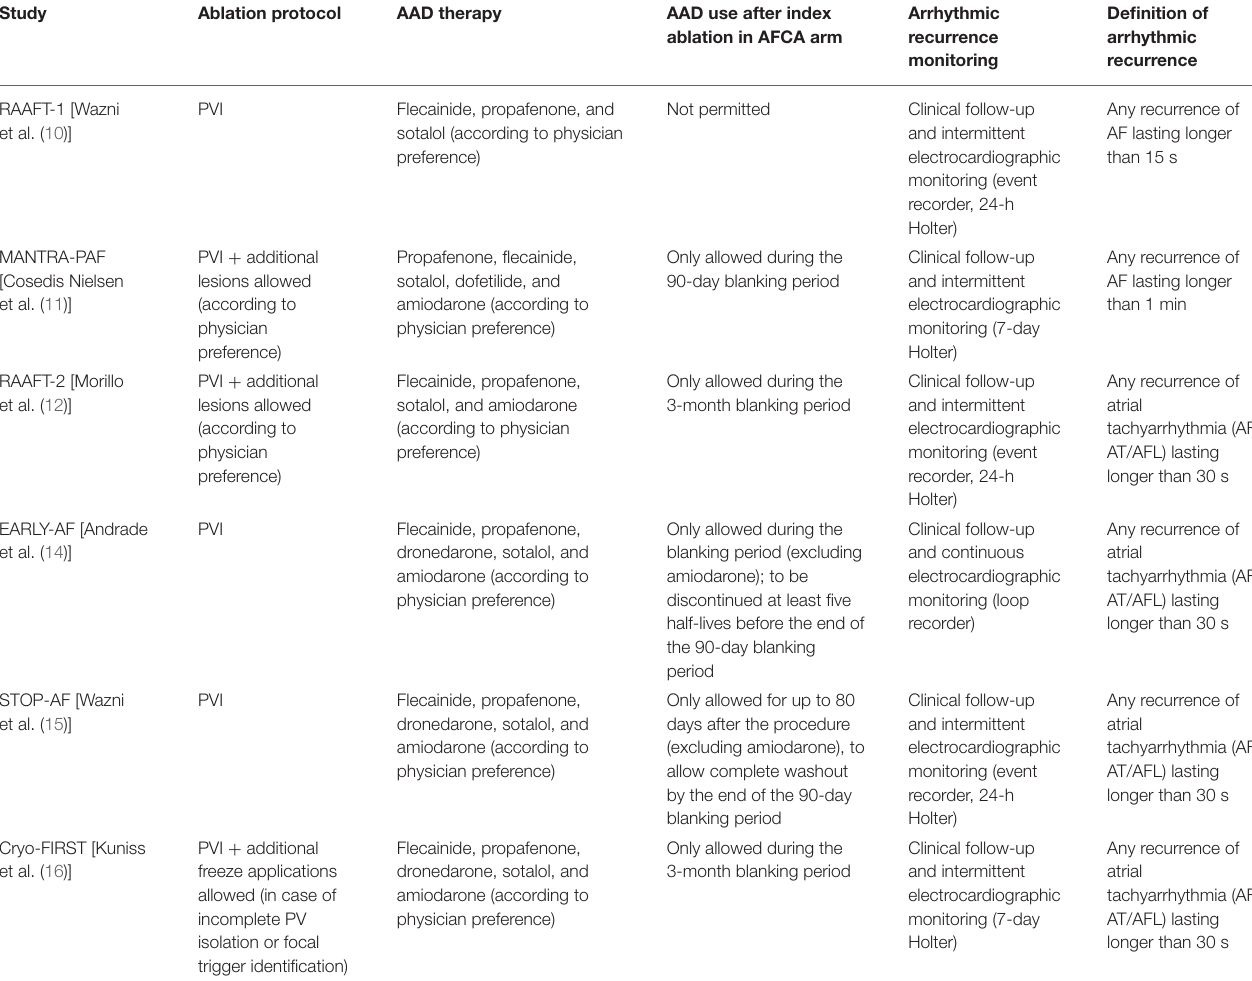
TABLE 2 | Study-specific ablation protocol, AAD use in both treatment arms, type of monitoring, and definition of arrhythmic